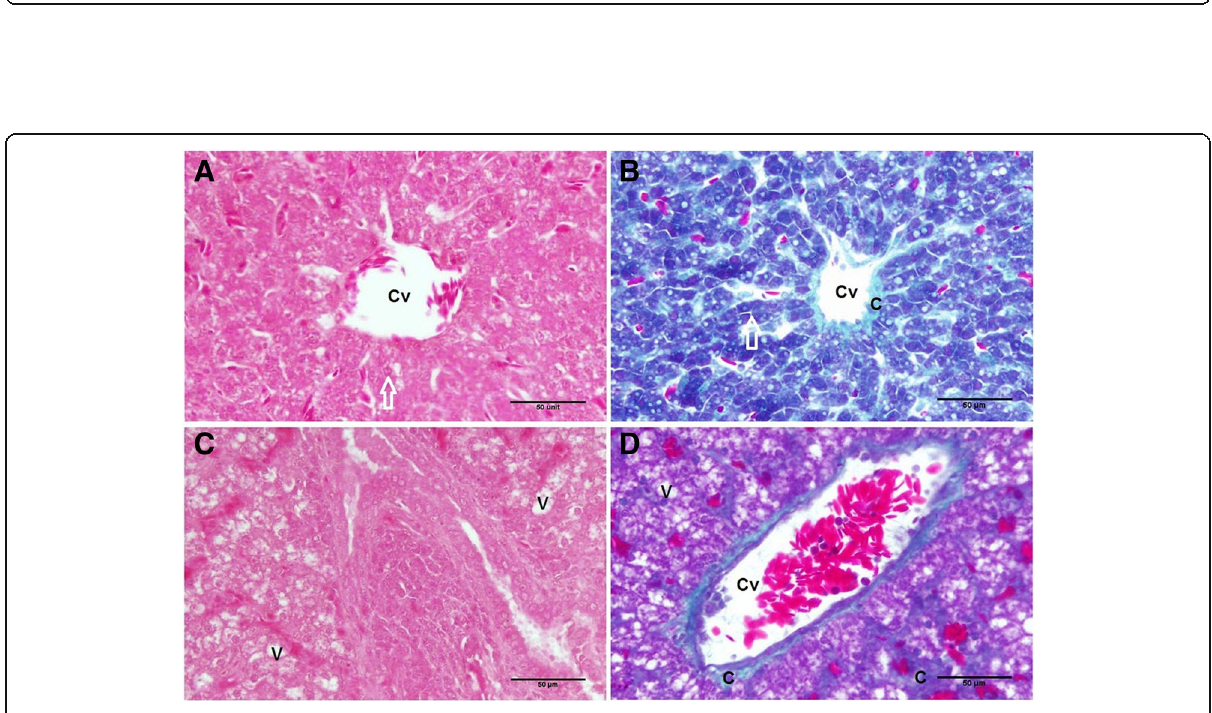
Fig. 4 Photomicrographs of hepatic tissue of black seed group stained with H&E stain ( a ) and crossmon trichrome stain ( b ) demonstrating the protective effect of black seed grains against hepatic damage induced by heat stress. The hepatic architecture in normal with hepatocytes arranged in hepatic cods (white arrow) around the central vein (Cv), which surrounded by less collagenous fibers (C). Very small vacuolated hepatocytes were found. c , d Photomicrographs of the propolis fed group stained with H&E stain ( c ) and crossmon trichrome stain ( d ) showing the presence of the heat-stressed-mediated damage with no protective effect on the hepatic tissue. Note severe hepatocytes vacuolation (V), swollen and congested central vein (Cv), and collagenous fiber depositions (C), bar = 50 μ